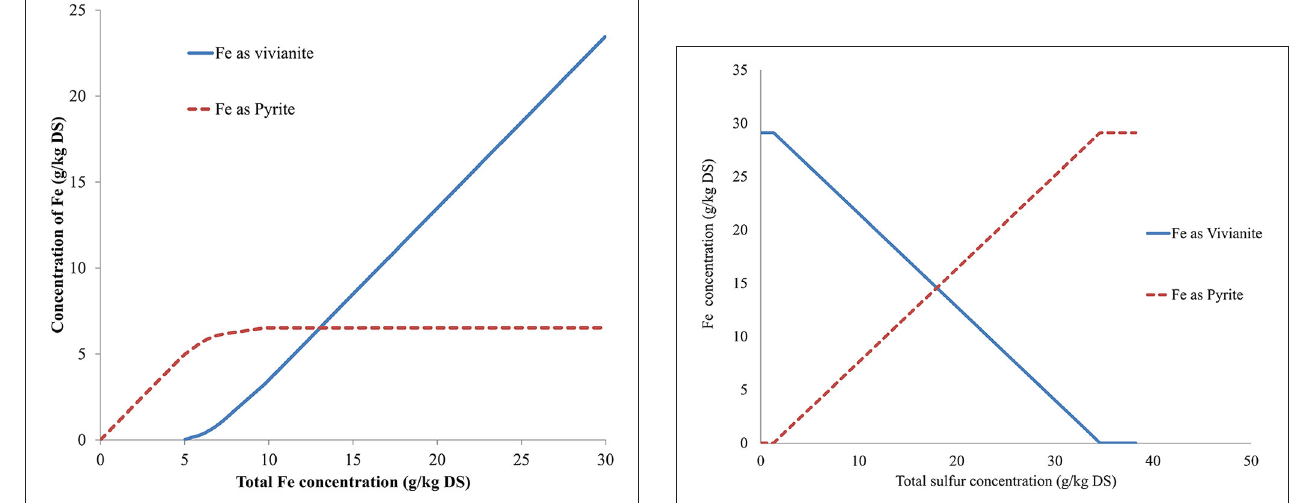
FIGURE 5 | Predicted iron fractionation in function of total iron concentration (average of the predicted results obtained from all anaerobically digested sludge under study).